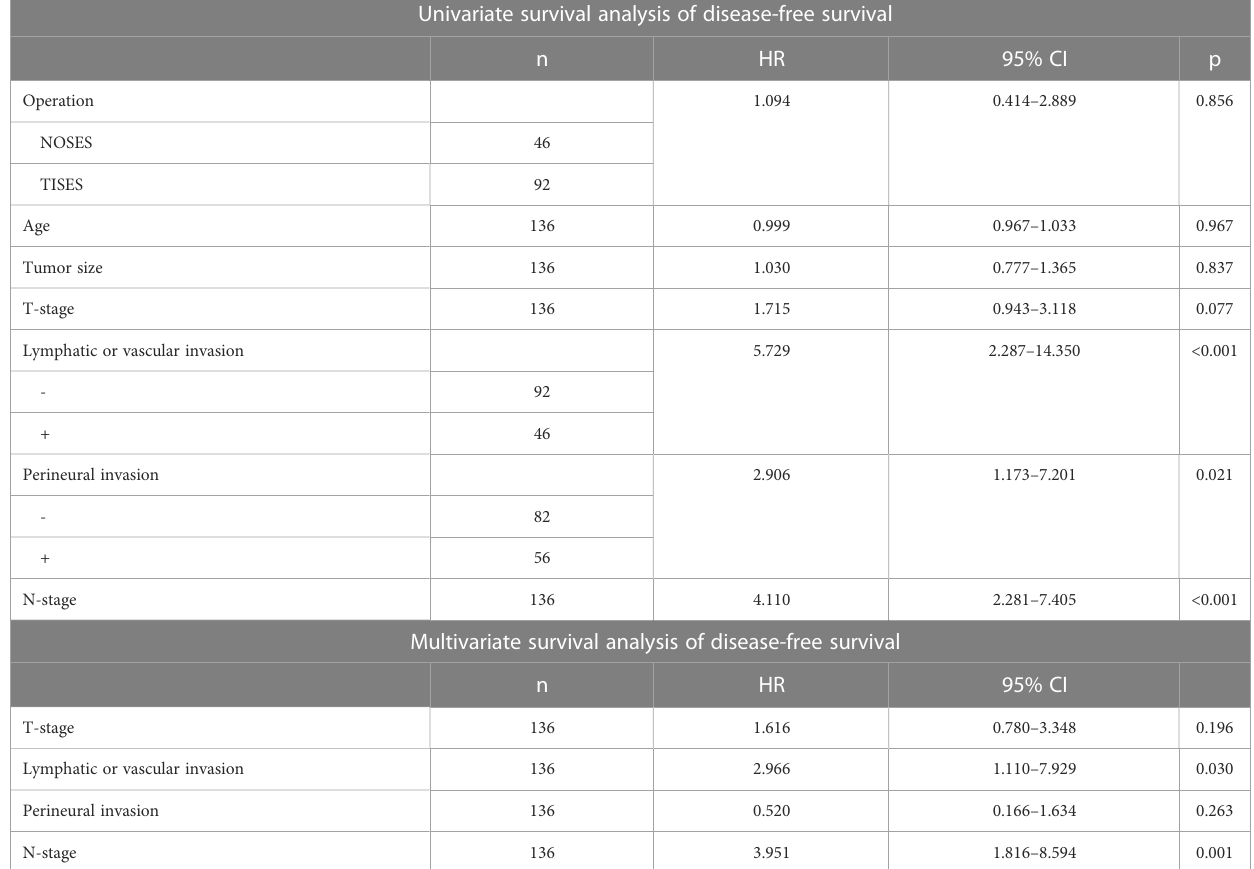
TABLE 6 Univariate and multivariate survival analysis of disease-free survival. Univariate survival analysis of disease-free